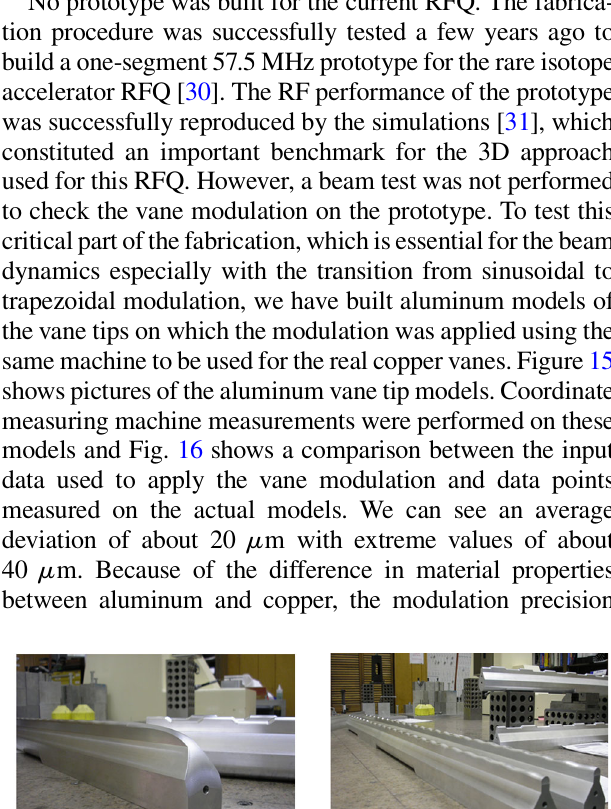
FIG. 16. Comparison of calculated vane profile (curves) and measured data points (dots) on the actual aluminum model (left) and corresponding deviations in (cid:4) m (right).